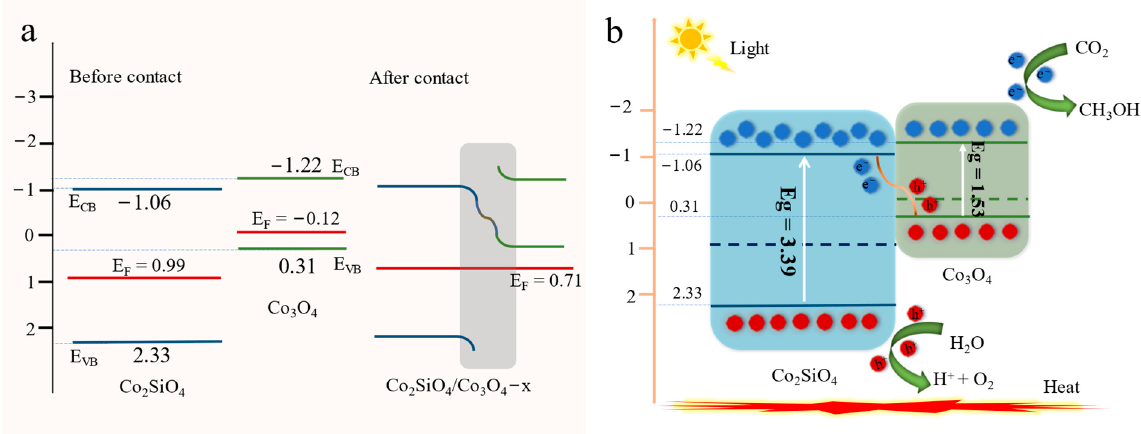
Figure 8. ( a ) Band structure and transfer route of photogenerated carriers before and after contact between Co 3 O 4 and Co 2 SiO 4 ; ( b ) schematic mechanism of photocatalytic conversion of CO 2 over Co 2 SiO 4 /Co 3 O 4 − x heterostructure under sunlight.